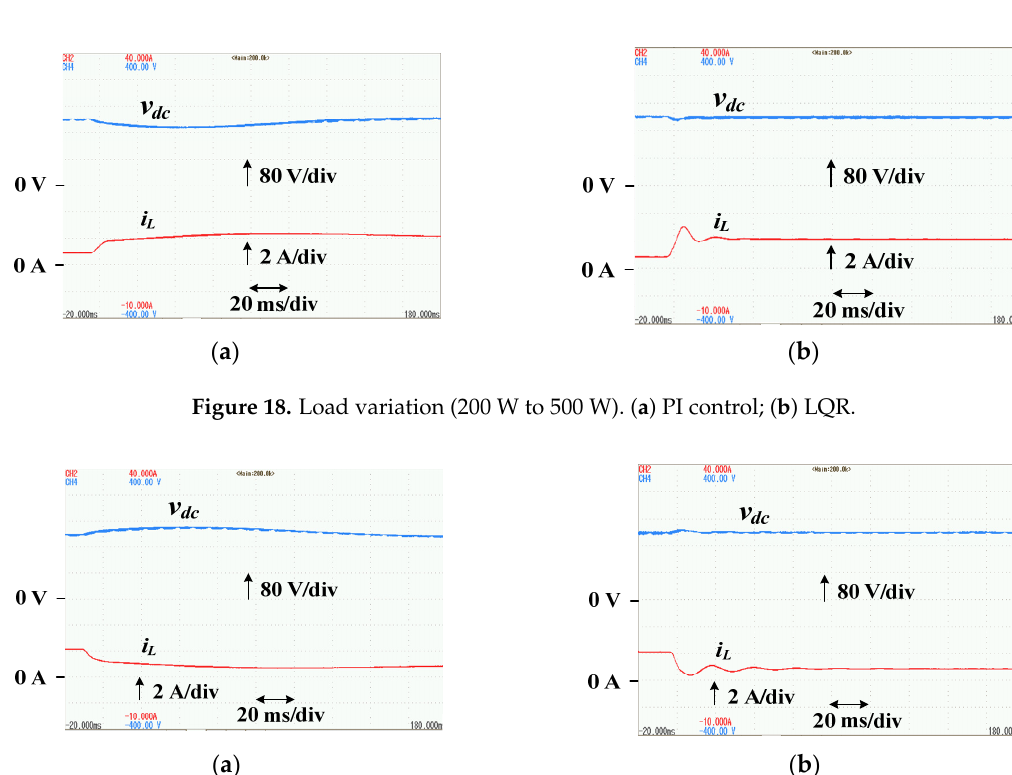
Figure 17. Step response (150 V to 200 V). ( a ) PI control; ( b ) LQR.